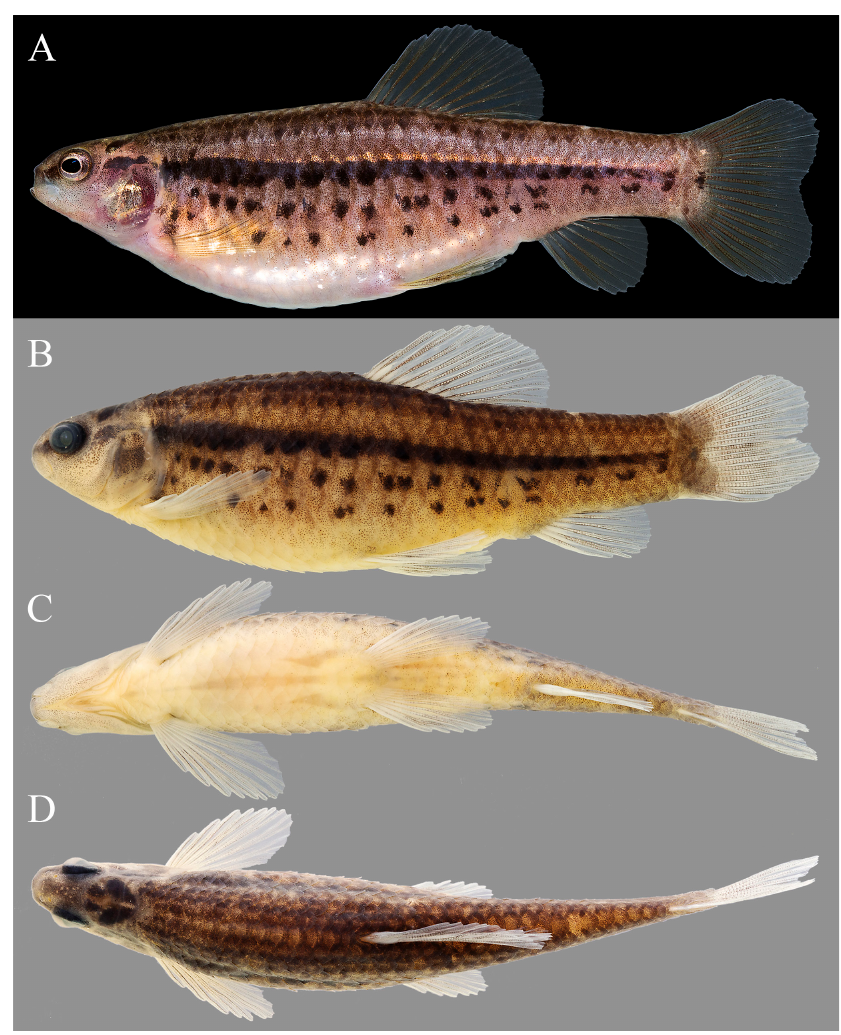
FIGURE 1 | Characidium onca , holotype, MZUSP 125807, 40.1 mm SL, male. A . Specimen in lateral view soon after collection; B – D . Preserved specimen in lateral dorsal, ventral